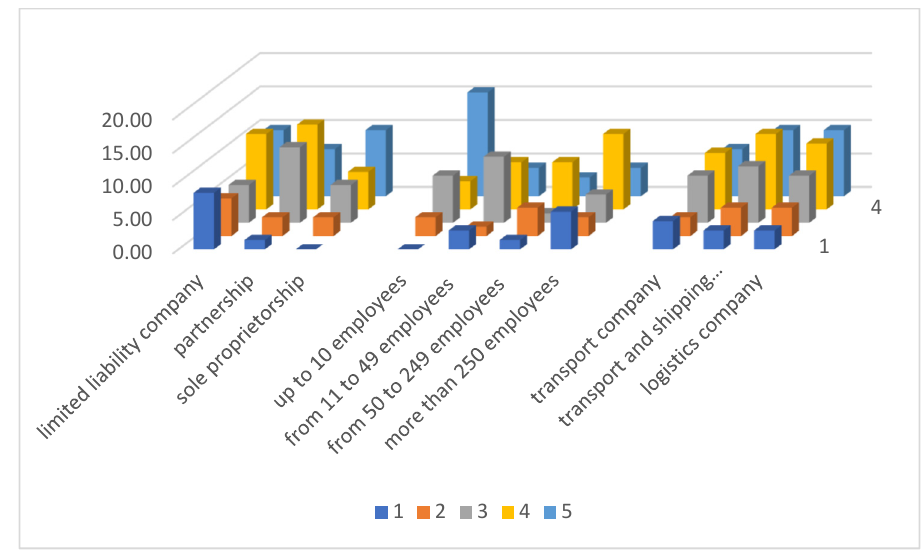
Figure 8. Energy price uncertainty and demand for electric vehicles—criteria organisational and legal form, employment structure, scope of activity .